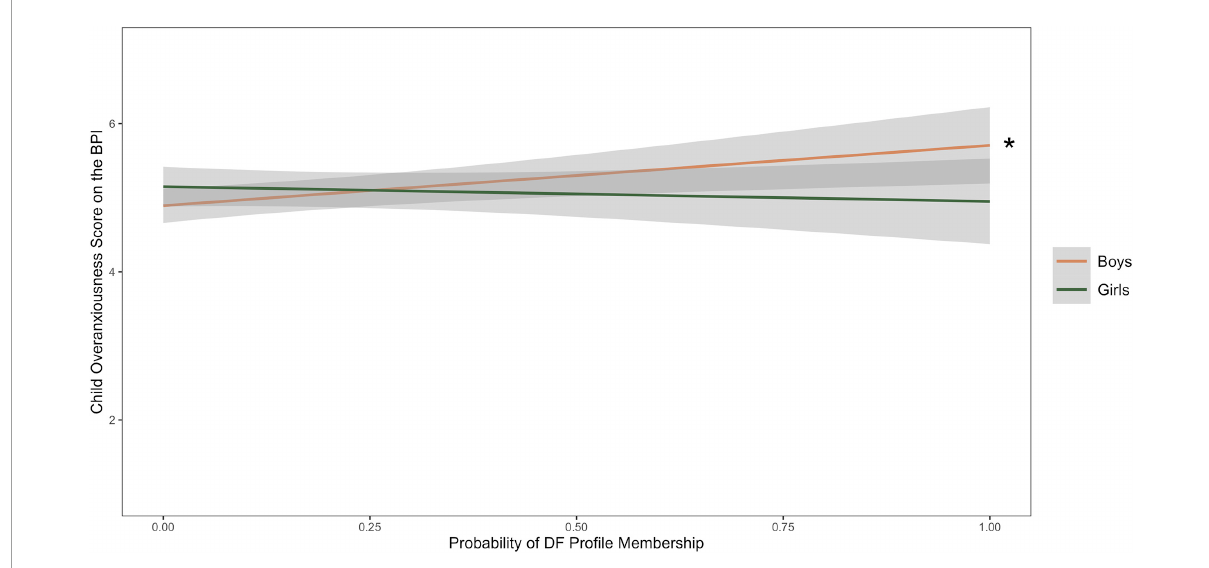
FIGURE2 Line graph depicting associations between the probability of dysregulated fear (DF) profile membership and child self-report of overanxiousness on the BPI, with child sex as a moderator. The symbol ∗ indicates a significant slope ( p <